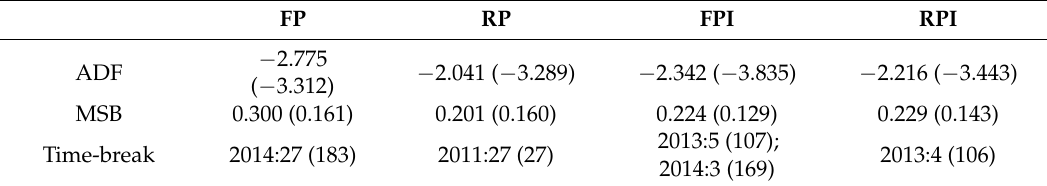
Table 3. Unit root and stationary tests with structural breaks (Carrion-i-Silvestre et al. 2009). FP